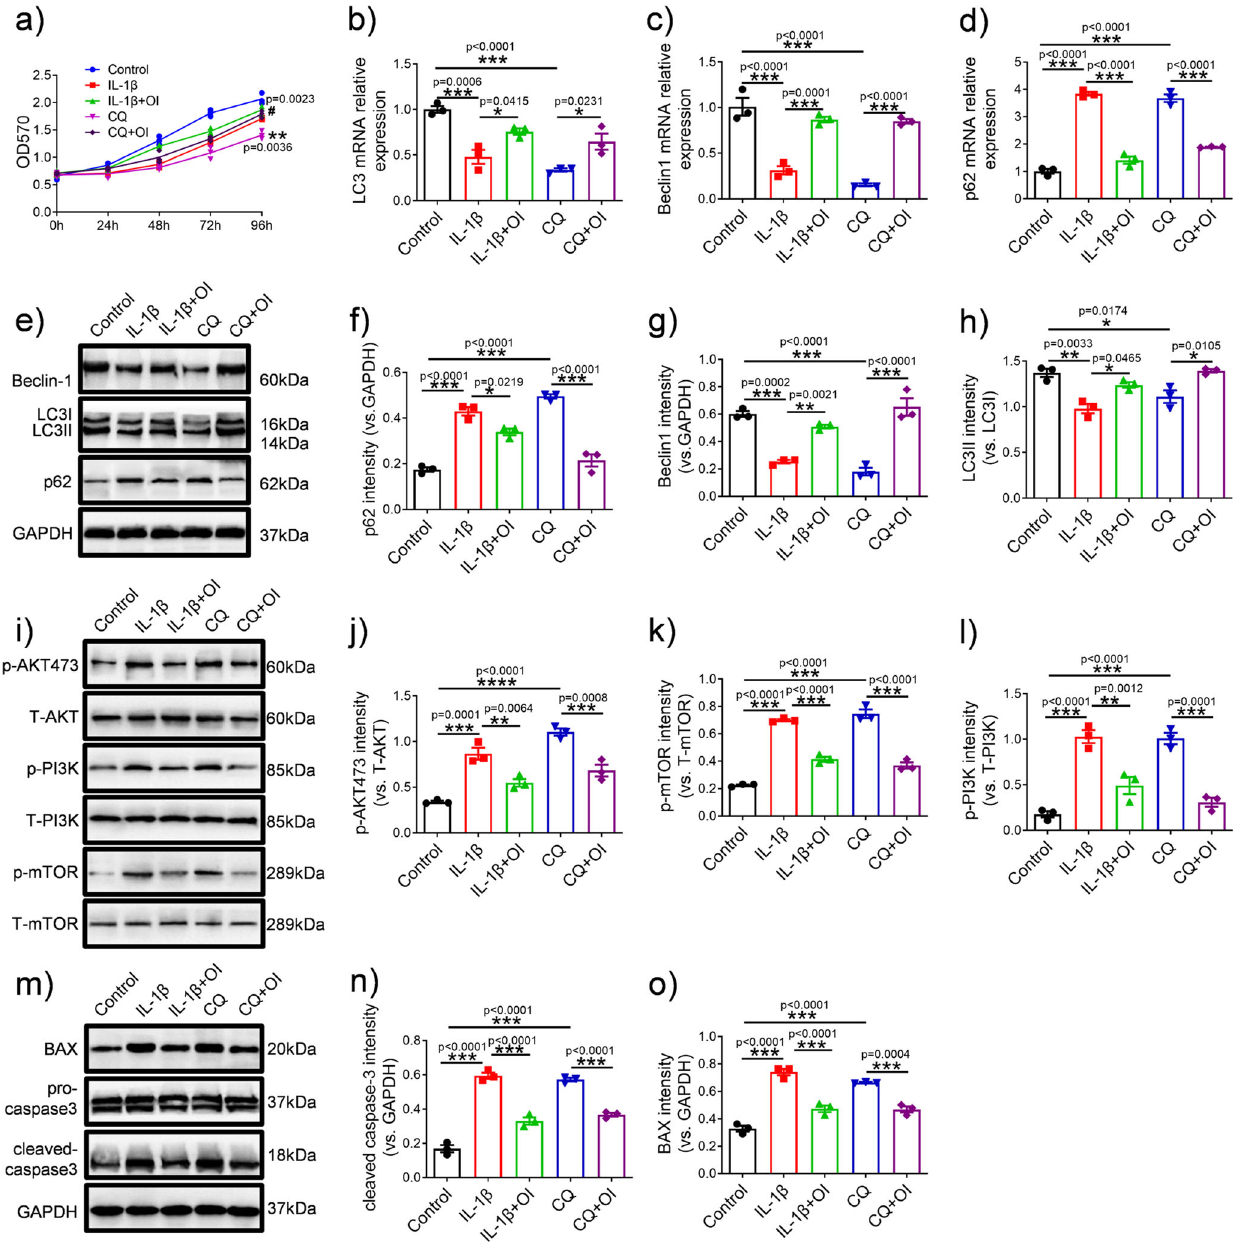
Fig. 4 OI induced autophagy marker expression through the PI3K/AKT/mTOR signalling pathway. a MTT assay showing the proliferation of C28/I2 cells treated with IL-1 β , OI and CQ ( n = 3). # P = 0.0023, the CQ + OI group vs. the CQ group, ** P = 0.0036, the CQ group vs. the Control group; b – d qRT- PCR was used to analyse the mRNA expression of LC3, Beclin-1, p62 in chondrocytes treated with IL-1 β , OI and CQ ( n = 3); e – h WB was performed